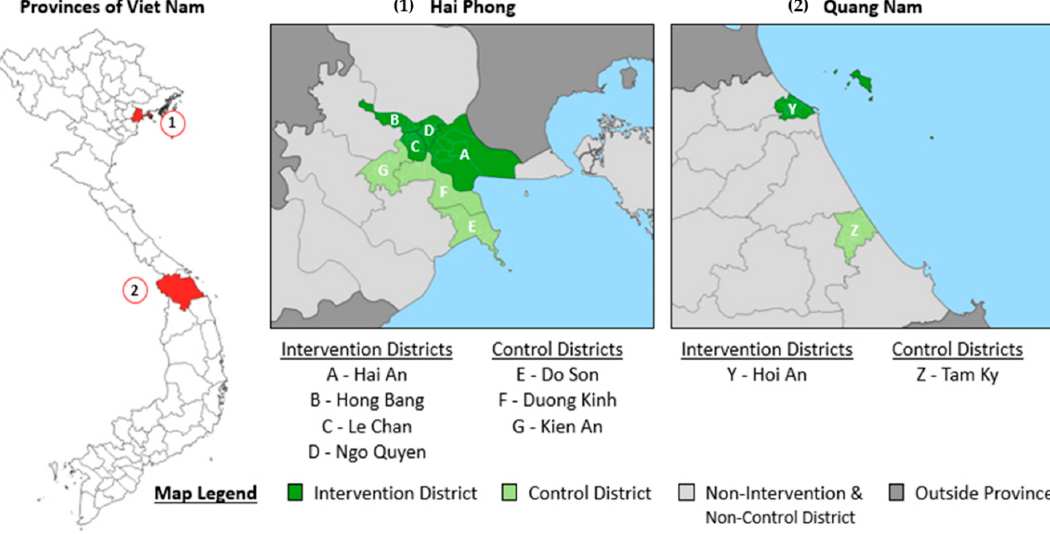
Figure 1. Map of intervention and control provinces and districts. Hai Phong and Quang Nam, Viet Nam. January 2018 to March 2019.